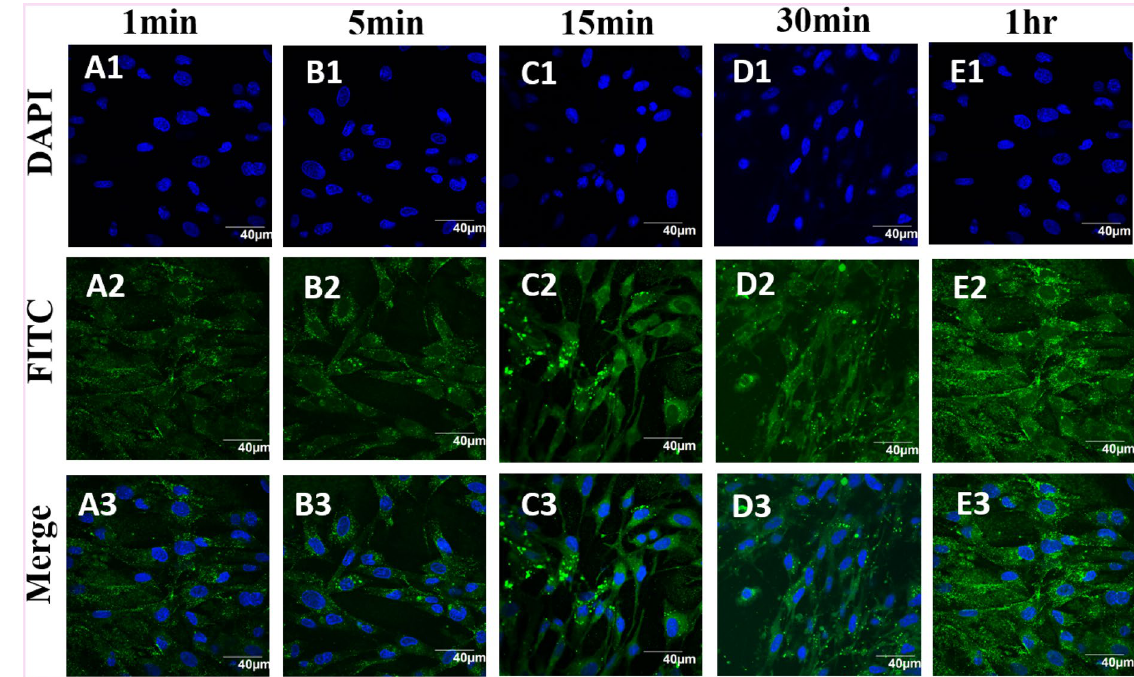
Figure 4. Confocal images of the BHK-21 cells exposed to PMMA nanoparticles (200 µg/mL) after 1 min ( A1 – A3 ), 5 min ( B1 – B3 ), 15 min ( C1 – C3 ), 30 min ( D1 – D3 ) and 1 h ( E1 – E3 ). From top to bottom rows: Hoechst stain in blue DAPI channel, NPs appear as green FITC channel, overlay of blue and green channels. The scale bar is 40 µm. The control experiment for all the time points are given in the supporting information Figure S6.